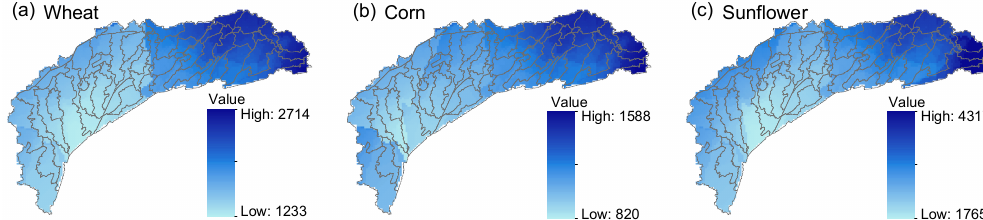
Figure 8. The spatial distribution of the blue water footprint of crop production in the HID (m 3 t − 1